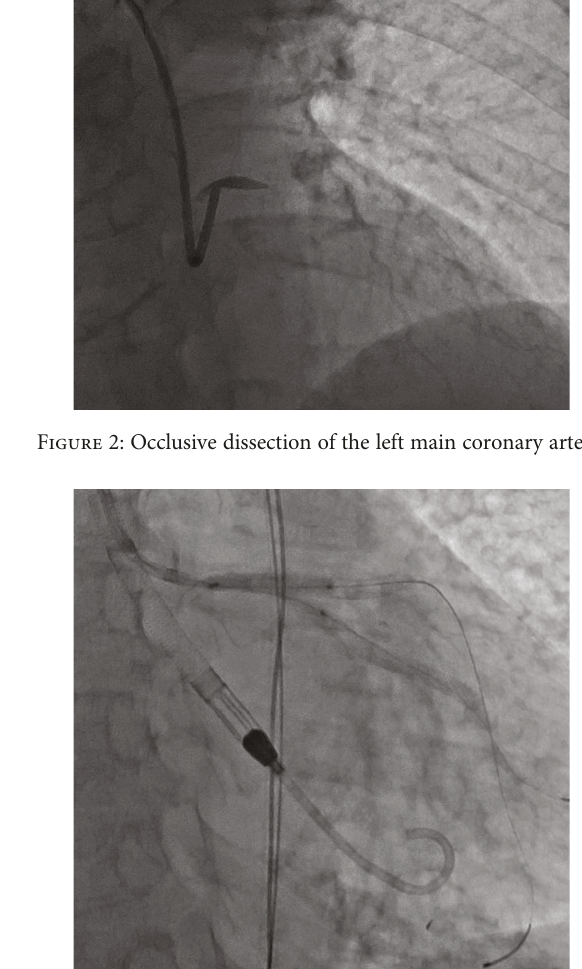
Figure 3: Final deployment of the left anterior descending and left circum fl ex coronary artery stents with a